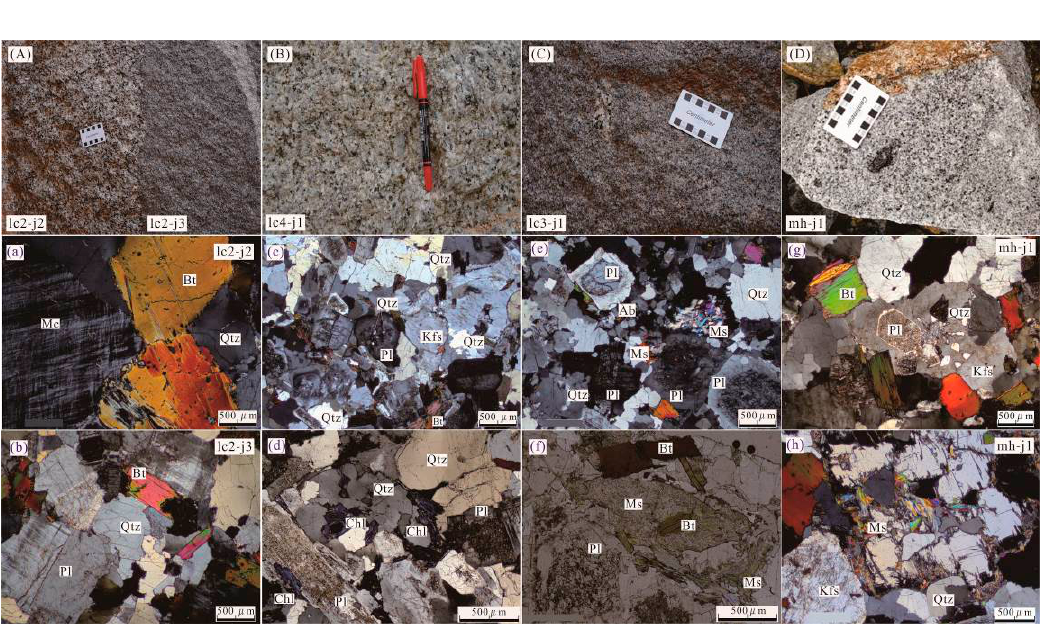
Fig.3 BSE image of REE minerals in the host rock of QN iRee deposit ： (a)&(c) monazite and zircon occurs as anhedron associated with apatite; (b) monazite and thorite occurs as anhedron associated with fluorapatite; (d)&(g) monazite, allanite zircon occurs as inclusion associated with biotite which artered to chlorite; (e)&(h) apatite and zircon occurs as euhedron associated with biotie which altered to chlorite; (f)&(i) Y-fluorapatite occurs as anhedron filled into the interspace of feldspar; Mnz － Monazite; Xtm － Xenotime; Aln － Allanite; Ap － Apatite; Fl-Ap － Fluorapatite; Trt － Thorite ; Zrn － Zircon; Fl － Fluorite